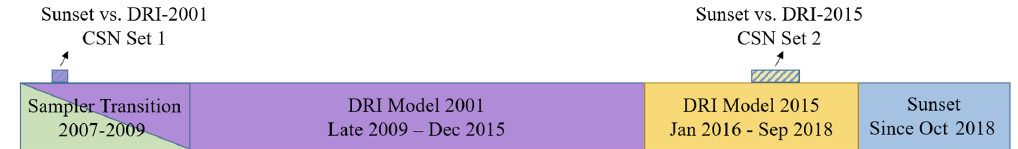
Figure 1. Timeline of CSN-wide changes in carbon analysis from 2007 to present, including changes in sample collection and analytical protocol during the “sampler transition” period from 2007–2009, as well as two instrumentation changes in 2016 and late 2018. The ap- proximate sample date ranges of the CSN 2007 (Set 1) and 2017 (Set 2) filter sets used in the inter-model comparisons are marked on the timeline. Table 1. Key attributes of three analyzer models (DRI model 2001, DRI model 2015, and Sunset analyzers) for comparison.